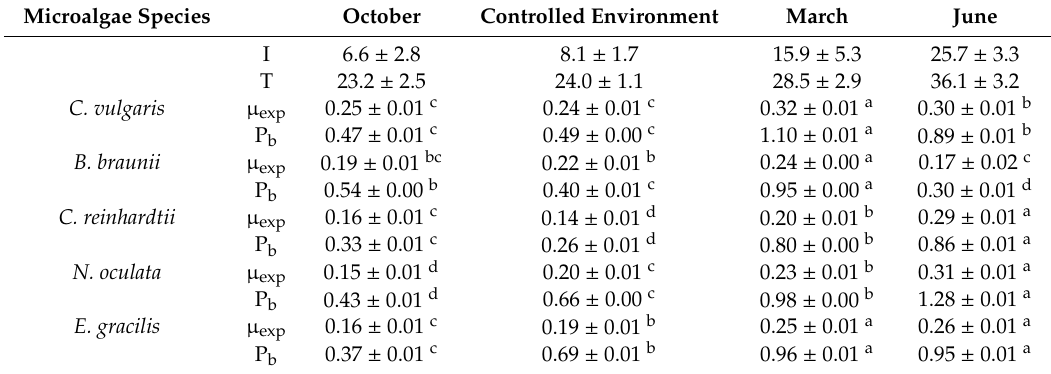
Values represent averages ± std. deviation (n = 6). Values in the same row bearing different superscripts indicate a statistically significant difference ( p < 0.05).